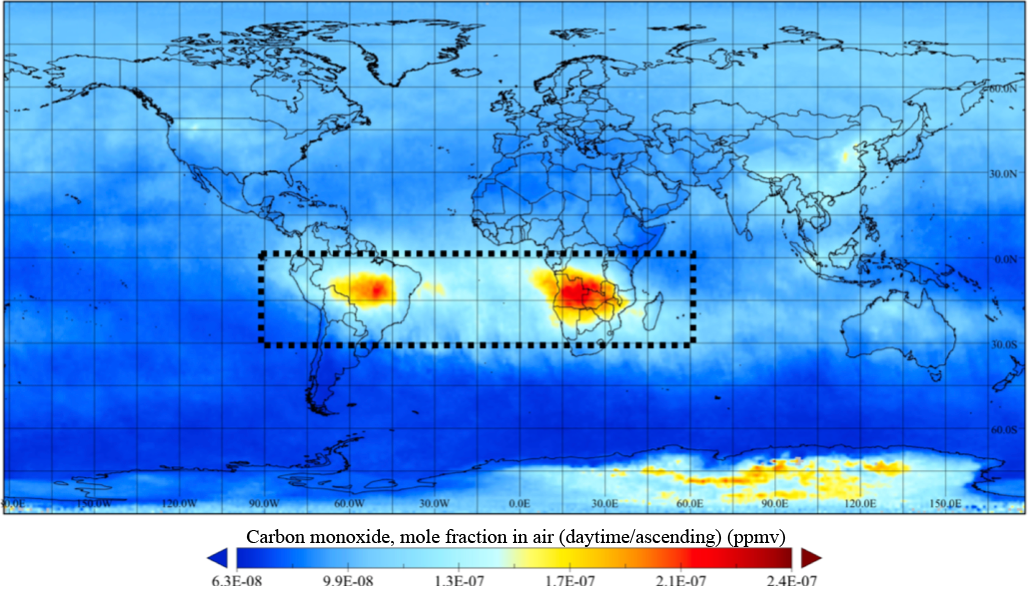
Figure 2. Time-averaged CO (ppmv) during the SAMBBA period (14 September–3 October 2012) from AIRS on board the AQUA satellite during daytime at 500hPa. The region of interest is indicated on the map. Table 2. Observations of the enhancement ratio ER [ (cid:49) O and plume age in tropical and subtropical 3 ] / [ (cid:49) CO ]